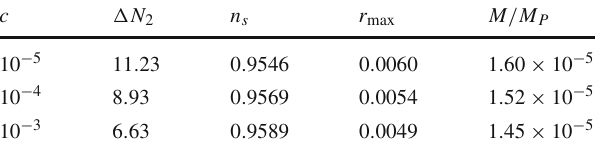
Table1 Thedurationofthesecondinflationarystage (cid:17) N 2 ,inflationary observables n s and r max , and the scalaron mass M for the three values of c used in our